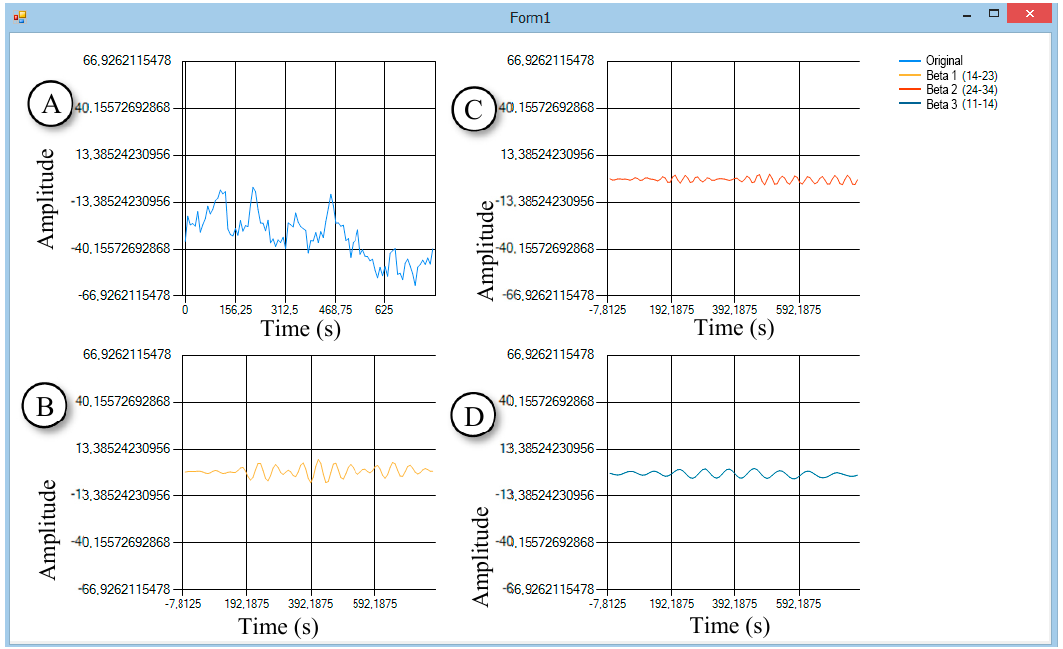
Figure 4. One of the first versions of the software. It works with static data (EEG recording files) using Butterworth finite impulse response (FIR) filters. Light blue ( A )—raw EEG. Yellow ( B )—beta 1 waves. Red ( C )—beta 2 waves. Dark blue ( D )—beta 0 waves.